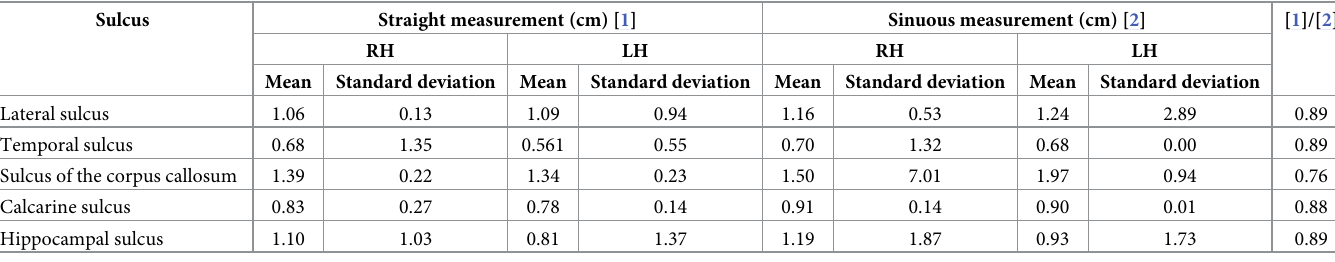
RH: right hemisphere, LH: left